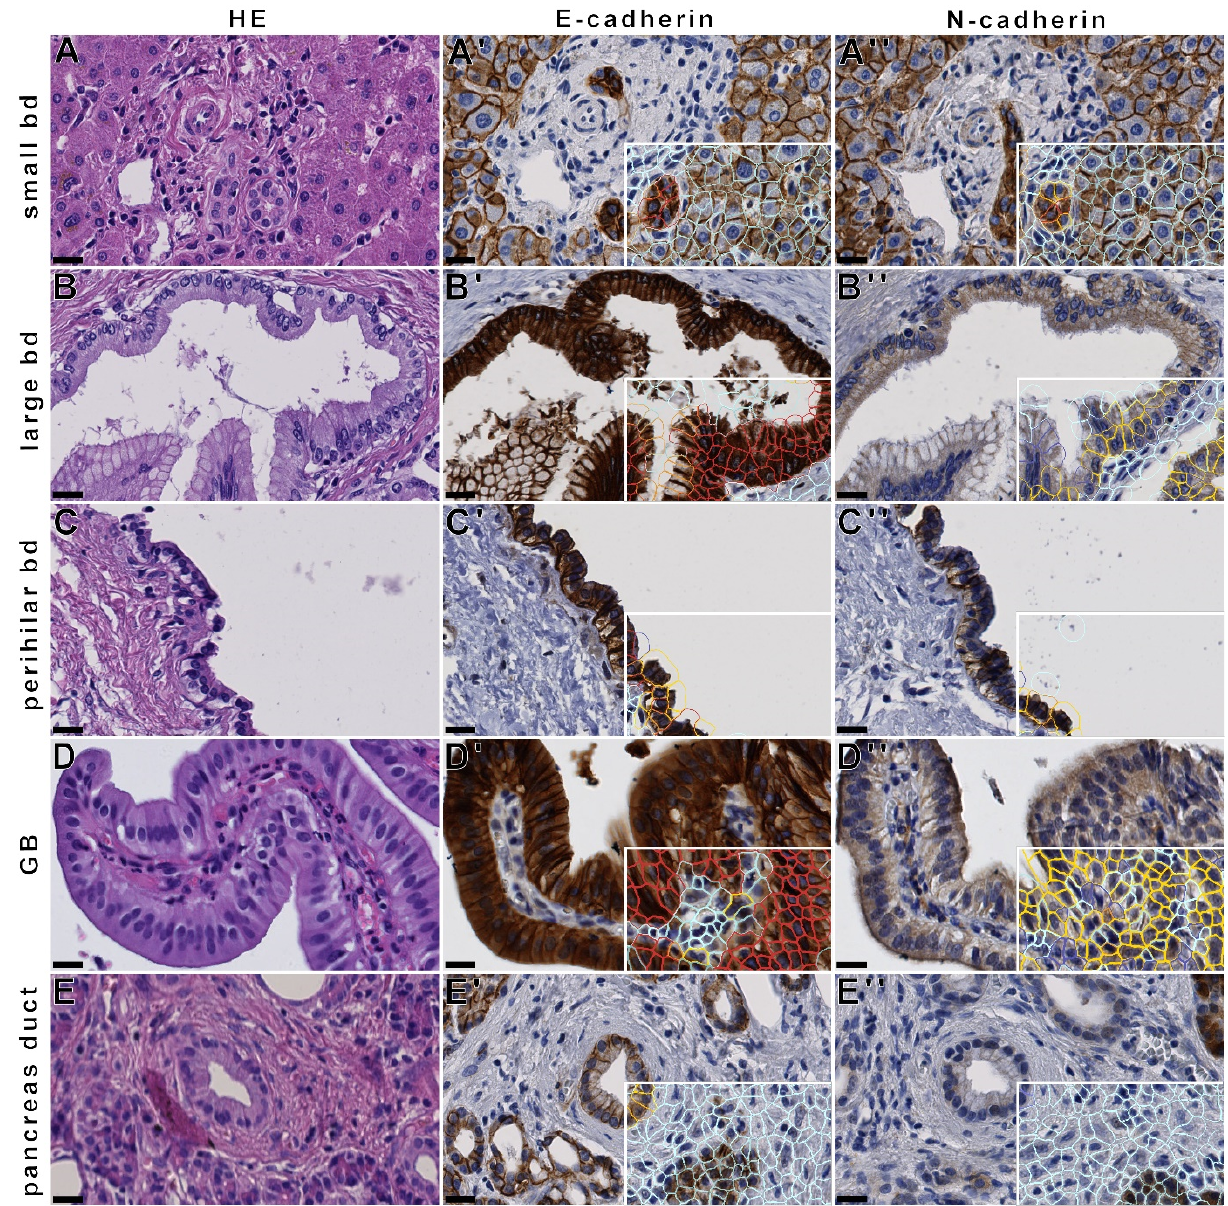
Figure 2. E- and N-cadherin expression in physiological epithelia of the human pancreatobiliary tract. Immunohistochemical analysis of E- and N-cadherins demonstrates strong E-cadherin expression in small ( A ) and large bile ducts ( B ) in human liver, in a perihilar bile duct ( C ), in gallbladder epithe- lium ( D ) and in pancreas ducts and acini ( E ), whereas N-cadherin expression declines from strong expression in intrahepatic and perihilar bile ducts to faint expression in gall bladder epithelium, with negative expression in pancreatic ducts. QuPath analysis is shown on the bottom right ( A’ – E’ , A” – E” ). ( A’ ): manual score 3.0, E-cadherin H-score 268.75; ( A” ): manual score 3.0, N-cadherin H-score 218.75; ( B’ ) : manual score 3.0, E-cadherin H-score 268.56; ( B” ): manual score 1.5, N-cadherin H-score 67.73; ( C’ ): manual score 3.0, E-cadherin H-score 212.39; ( C” ): manual score 2.5, N-cadherin H-score 85.43; ( D’ ): manual score 3.0, E-cadherin H-score 290.83; ( D” ): manual score 2.0, N-cadherin H-score 58.47; ( E’ ): manual score 2.5, E-cadherin H-score 105; ( E” ): manual score 0.5, N-cadherin H-score 8.33. Cells with colored border: white—stromal cells, blue—epithelial cell 0, yellow—epithelial cell 1+, orange—epithelial cell 2+, red—epithelial cell 3+. Black bar: 50 µ m ( A – E , A’ – E’ , A” – E” ) Black bar: 20 µ m ( A – E , A’ – E’ , A” – E”